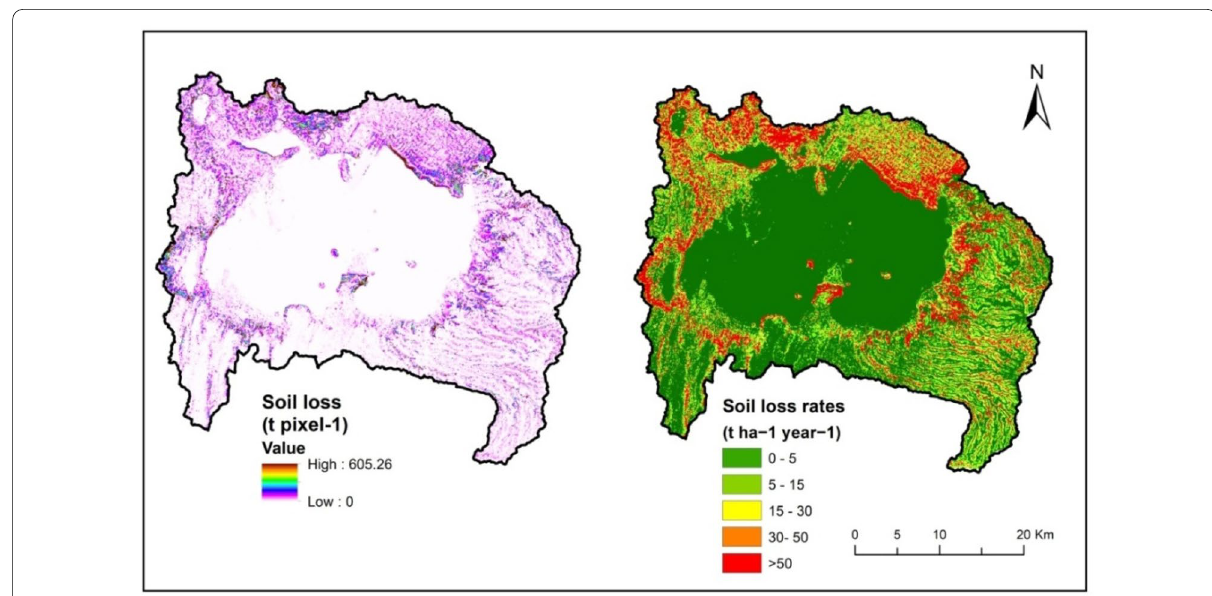
Fig. 4 Soil erosion rate in the Lake Hawassa watershed